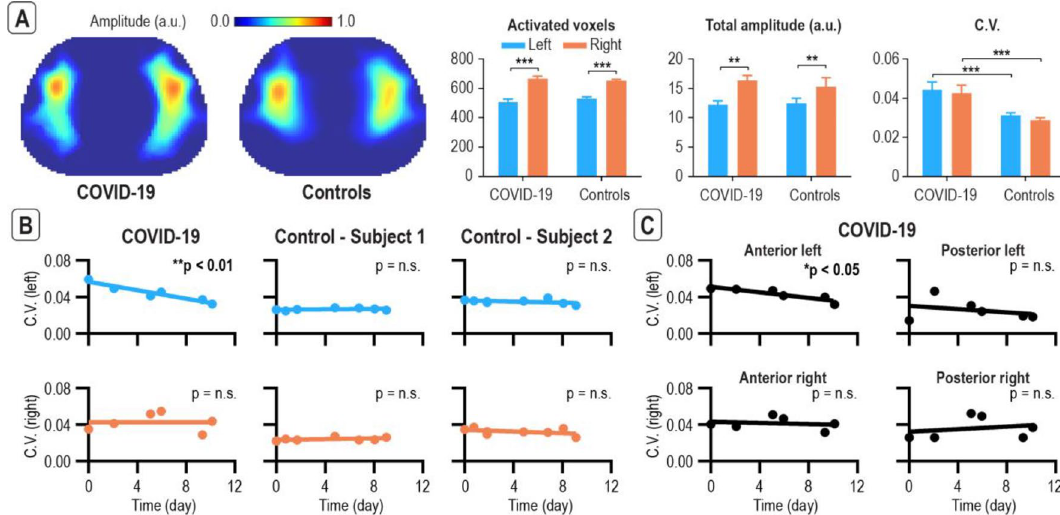
Figure 6. EIT with novel guided breathing paradigm close-to-effortless can detect regional lung deterioration followed by a recovery for a COVID-19 discharged subject. COVID-19 discharged subject was longitudinally monitored along with two age- and gender-matched controls ( A ) The COVID-19 discharged subject had higher C.V., suggesting lung function deterioration. Note the right lung has significantly more activated voxels and significantly higher total amplitude. ( B ) C.V. significantly decreased across time in the left lung of the COVID- 19 discharged subject, suggesting a functional deterioration at the beginning followed by a recovery. ( C ) Regional analysis further pin-pointed deterioration and recovery in the anterior left lung. * p < 0.05, ** p < 0.01, and *** p < 0.001. Error bars indicate ± standard error of mean. Abbreviations: arbitrary unit (a.u.); non- significant (n.s.); coefficient of variation